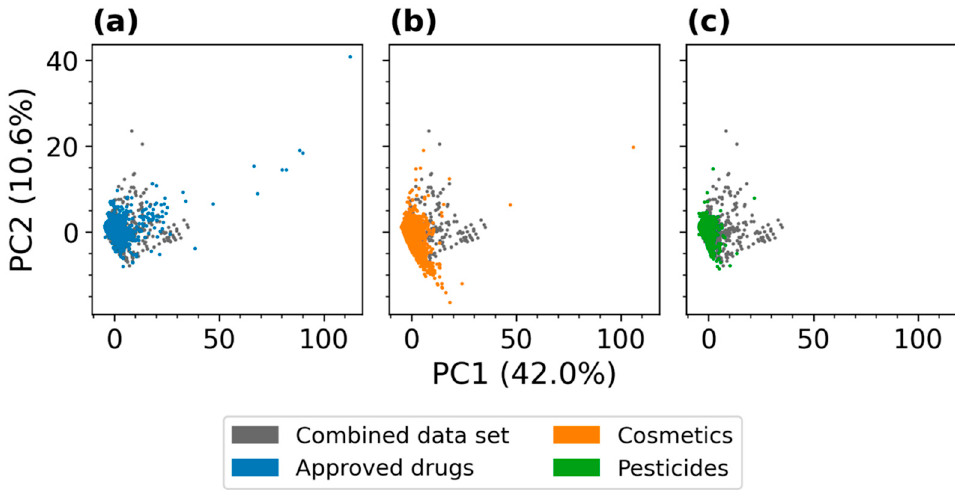
activity labels were rejected during data processing (see Section 3 Materials and Methods for details).